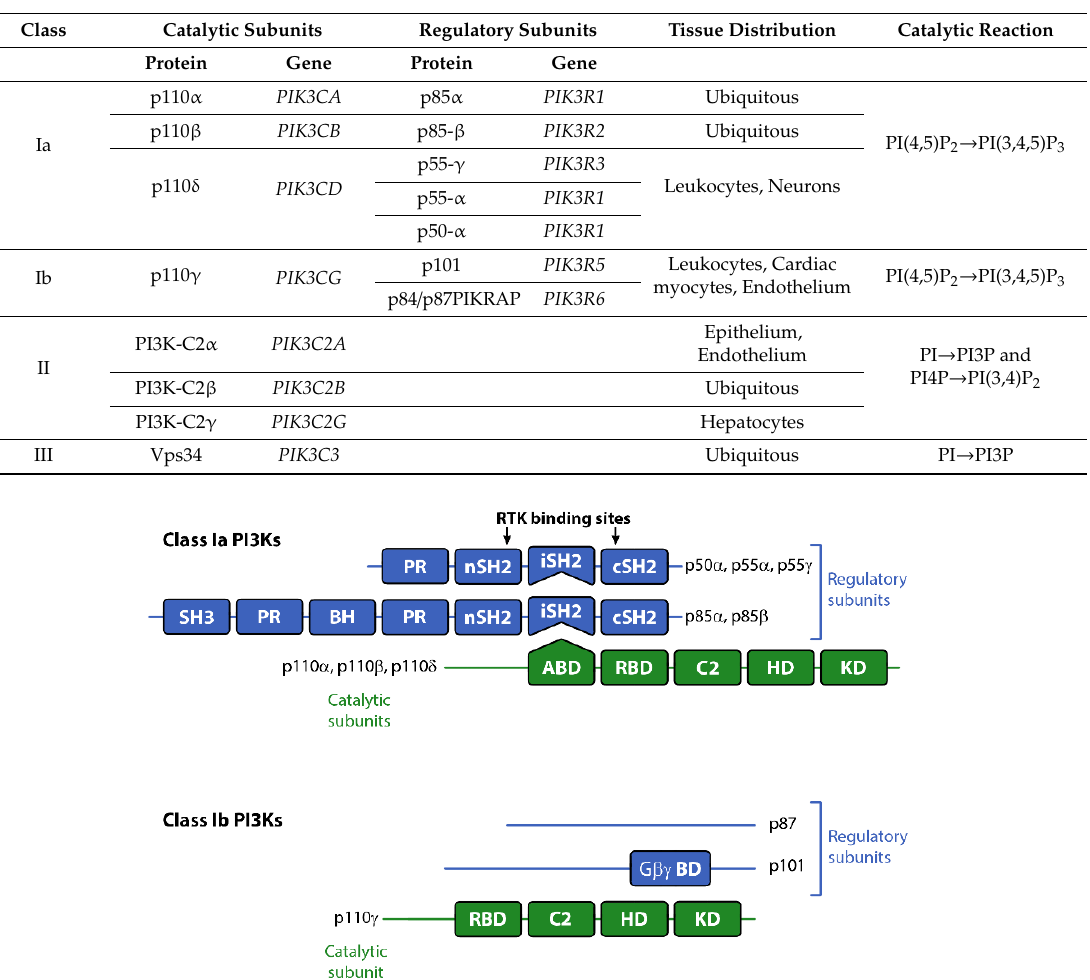
Figure 1. Schematic representation of Class I PI3K catalytic and regulatory subunits. Abbreviations: ABD, adaptor binding domain; BH, breakpoint cluster region homology domain (Rho-Gap-like domain); C2, C2 domain; G βγ BD, G βγ binding domain; HD, helical domain; KD, kinase domain; iSH2: inter-SH2 domain (p110 binding domain); PR, proline-rich domain; RBD, RAS binding domain.